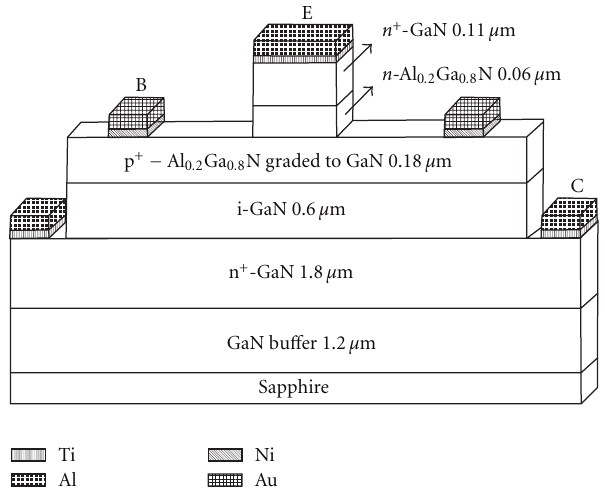
Figure 1: Schematic diagram of the studied npn graded-base AlGaN/GaN